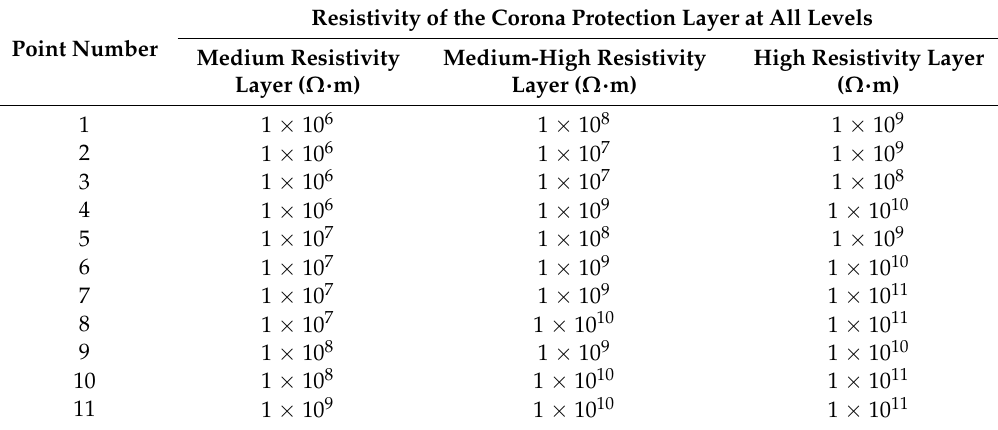
Table 2. Resistivity of the corona protection layer for all